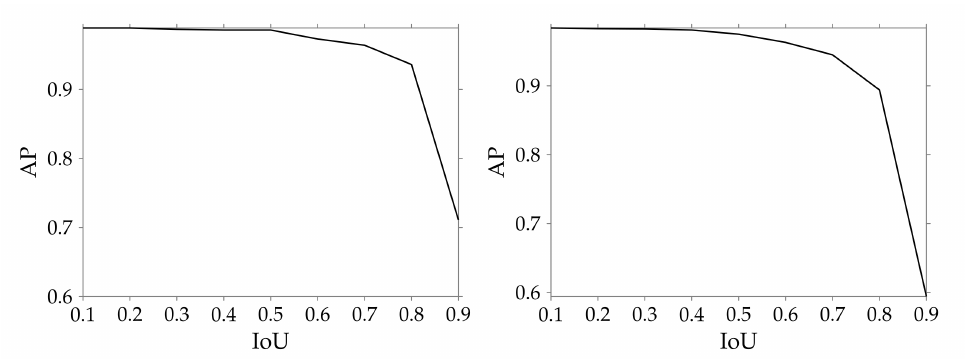
Figure 5. Average precision (AP) results with different IoU detection thresholds on sphaera data for YOLOv5 (S-VED extended , 640 × 640) ( left ) and for Faster-RCNN (S-VED extended , 1280 × 1280) ( right